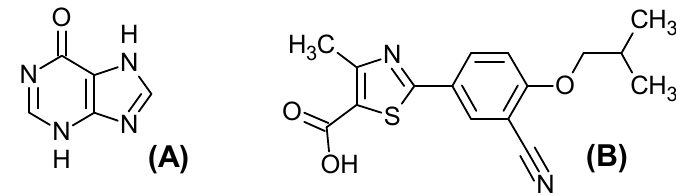
Figure 7. Control Ligands 2D structure: ( A ) hypoxanthine (HPX) and ( B ) Febuxostat (FBX). The molecular docking method identified a conformation that allows the ligand also to interact with the active sites for hypoxanthine (PDB 3 NRZ) that around the α -helix between the amino acids